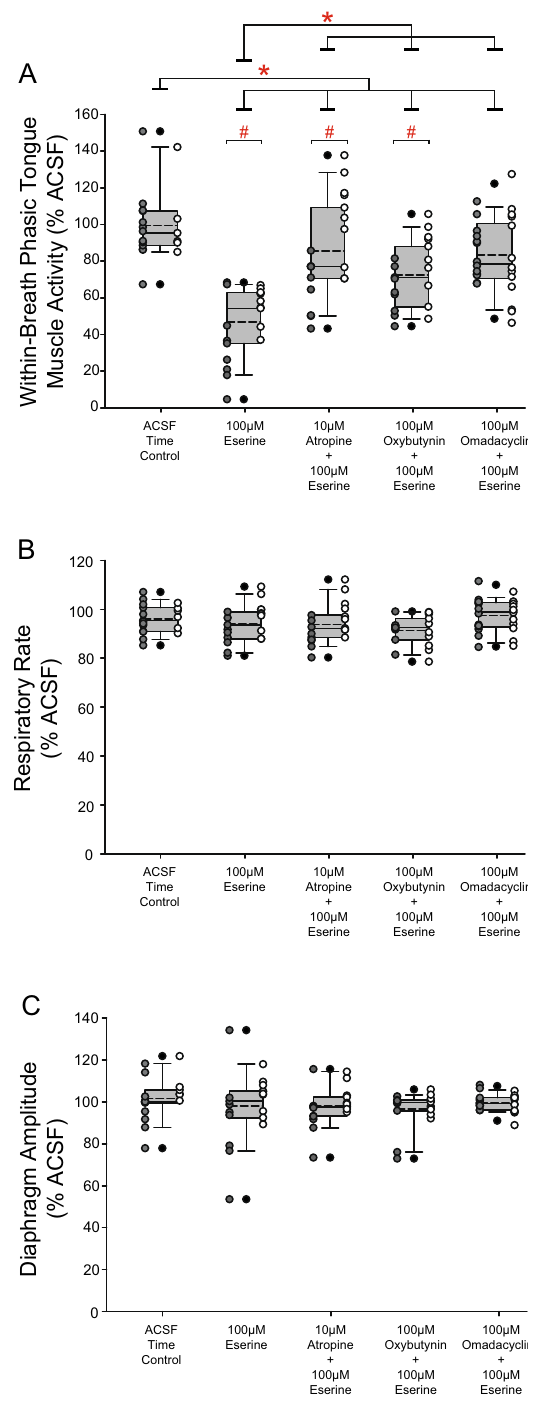
Figure 8. Relative efficacy of the antimuscarinic agents at the HMN in Study 1 in reducing eserine-induced tongue motor suppression and ACSF time controls. Individual data (males, gray round symbols on left of each bar; females, white symbols on right of each bar) and group data (population of males and females combined, grey bar) showing respiratory motor responses across protocols. Data are normalized to the baseline ACSF control period in each individual. Box and whisker plots show individual and group data comprising the plot (median (dashed line), mean (solid line), 25th and 75th percentiles) for within-breath phasic tongue muscle activity ( a ), respiratory rate ( b ), and diaphragm amplitude ( c ). * and # indicate p ≤